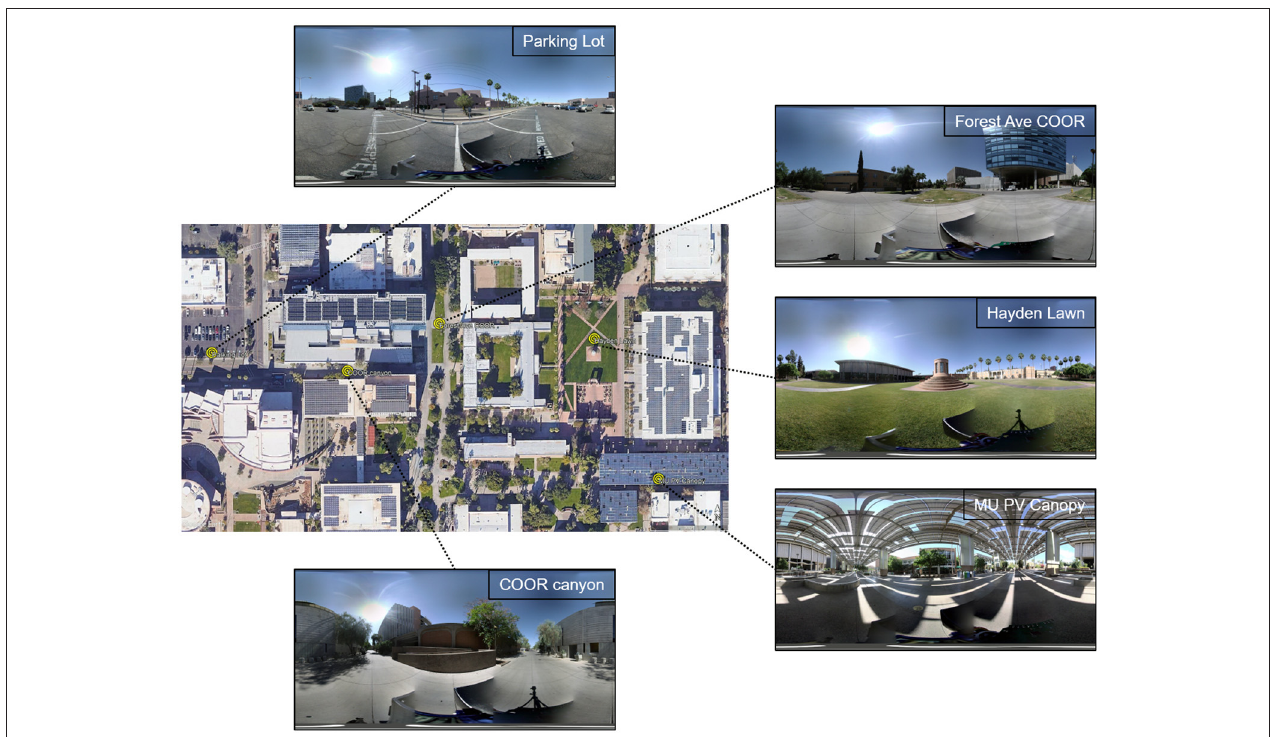
FIGURE 1 | Experiment locations on ASU Tempe campus. Panorama images of each location showing the surroundings and different conditions.